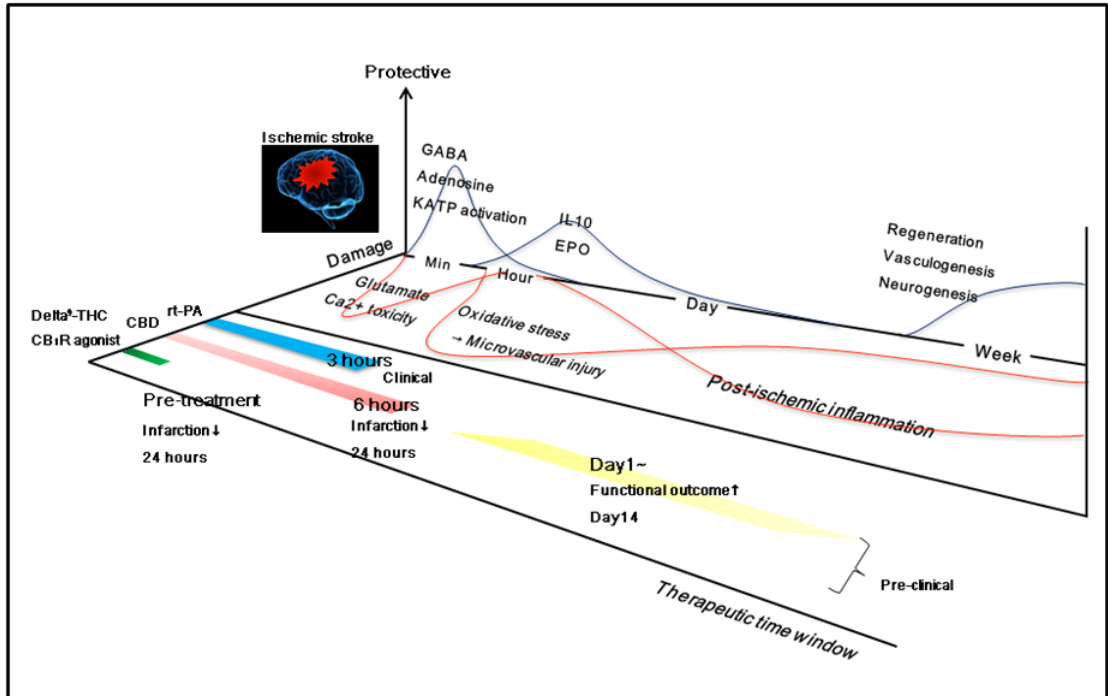
Figure 2. Therapeutic time window of CBD and delta 9 -THC in pre-clinical